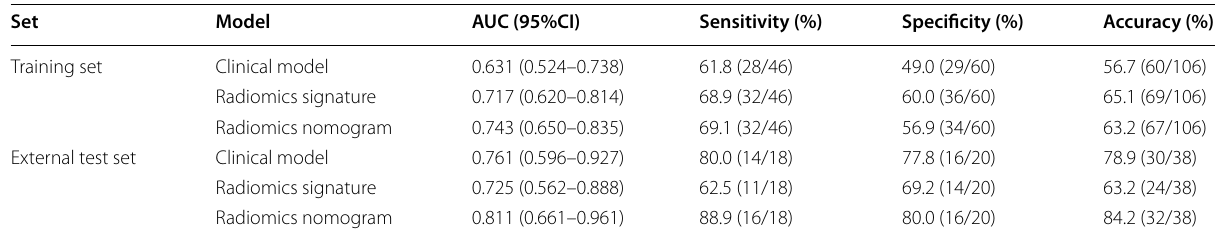
Table 2 Diagnostic performance of the clinical factor model, radiomics signature, and radiomics nomogram for detection of intraplaque